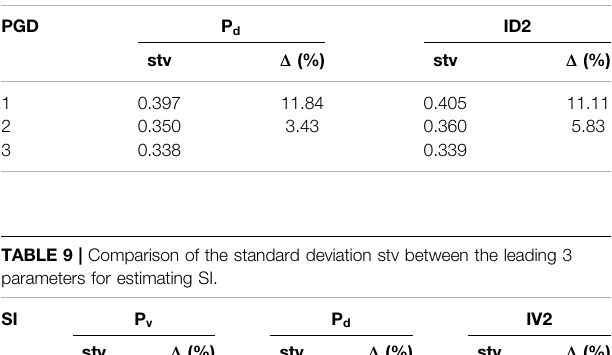
TABLE 8 | Comparison of the standard deviation stv between the leading 2 parameters for estimating PGD.